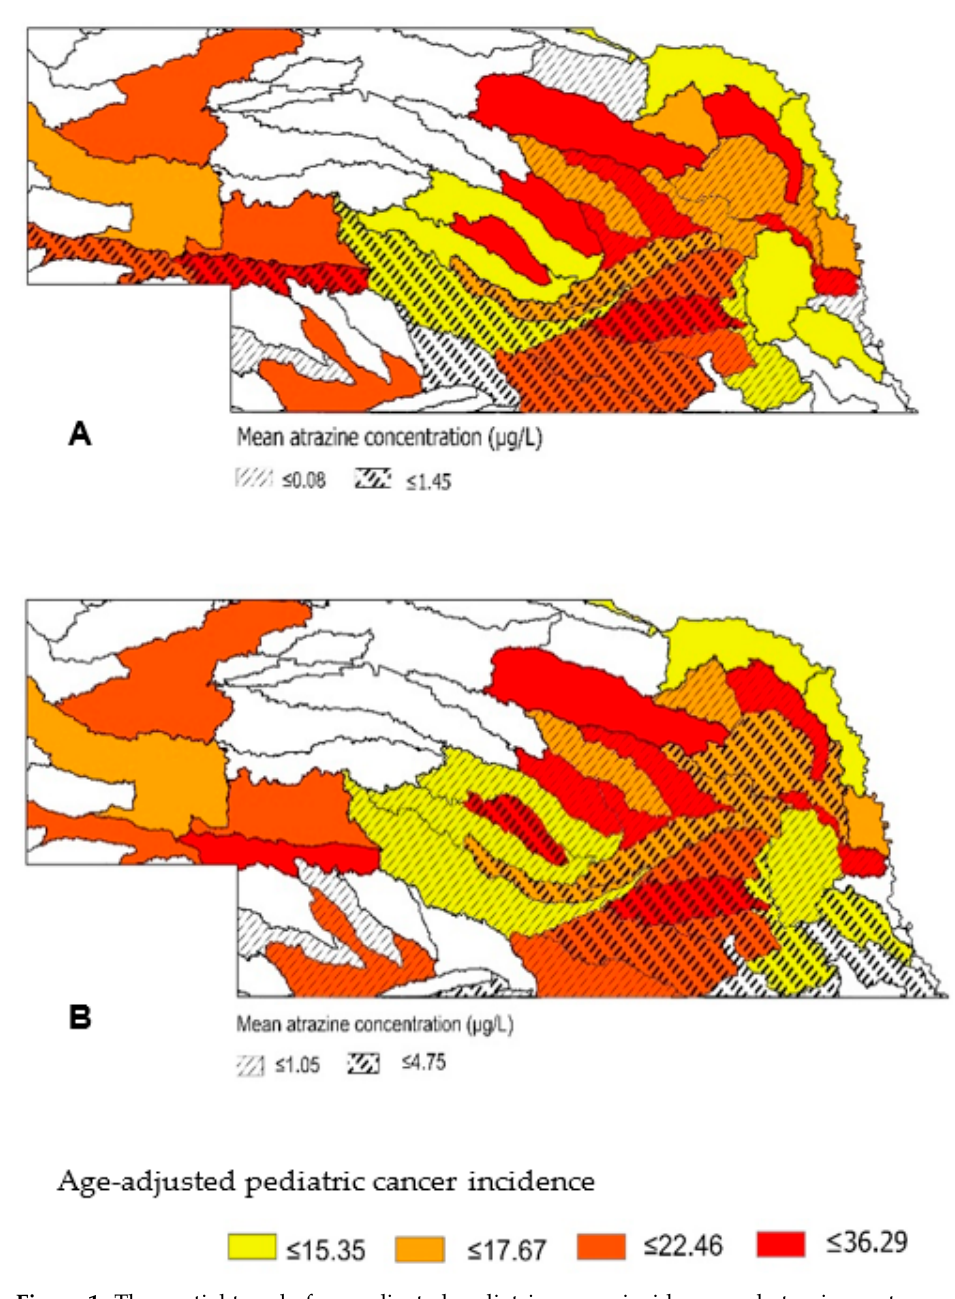
Figure 1. The spatial trend of age-adjusted pediatric cancer incidence and atrazine water concentration by watershed boundaries in Nebraska ( A —Ground & B —Surface). Note: The atrazine concentration displayed on panels A & B contains the two highest categories (medium and